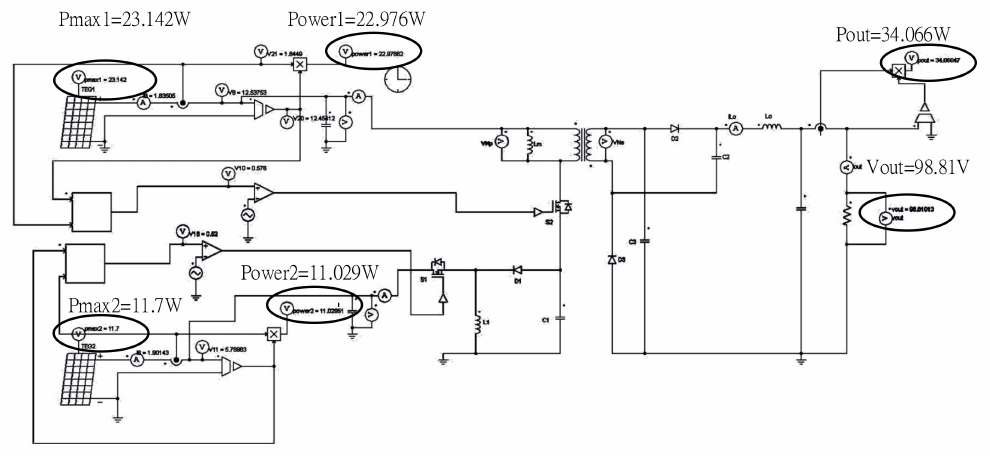
Figure 17. Simulation example